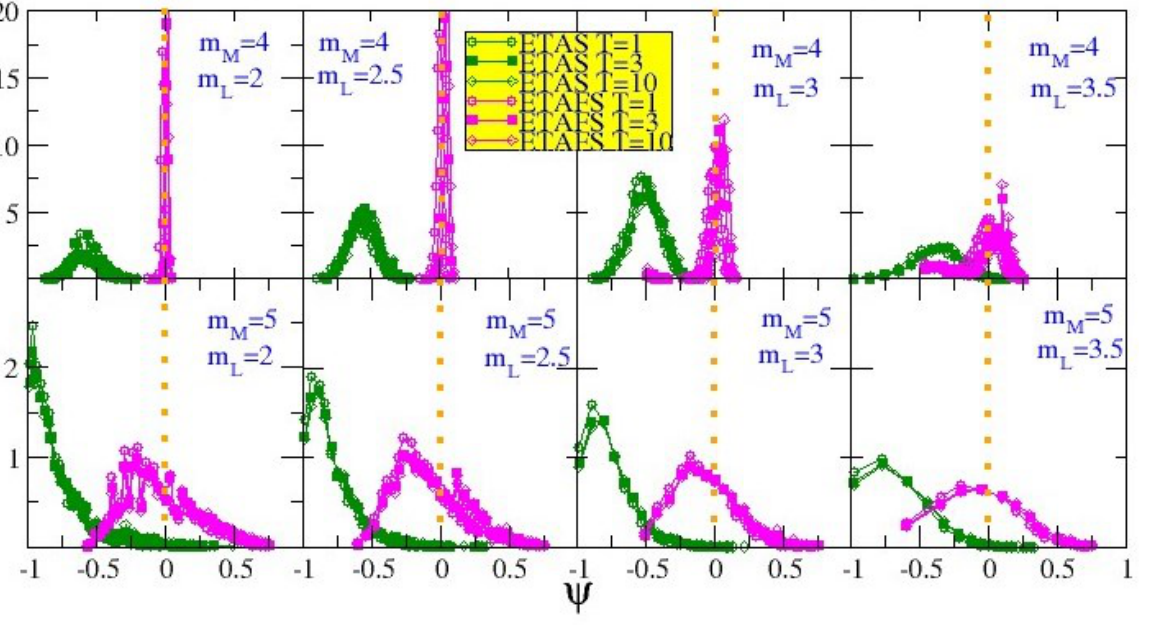
Figure 5. The fraction of numerical subsets H ( ψ ) of the ETAS and ETAFS simulated catalogue, with n X F , j ( T , R , m L , m M ) − n F ( T , R , m L , m M ) = ψ ± 0.005. Results are for different values of a number of foreshocks n X F , j ( T , R , m L , m M )+ n F ( T , R , m L , m M ) time window T . Moving horizontally from left to right, m L = 2,2.5,3, and 3.5, whereas from top to bottom, m M = 4 and 5. The orange dashed line indicates the optimum description of the seismicity ψ =